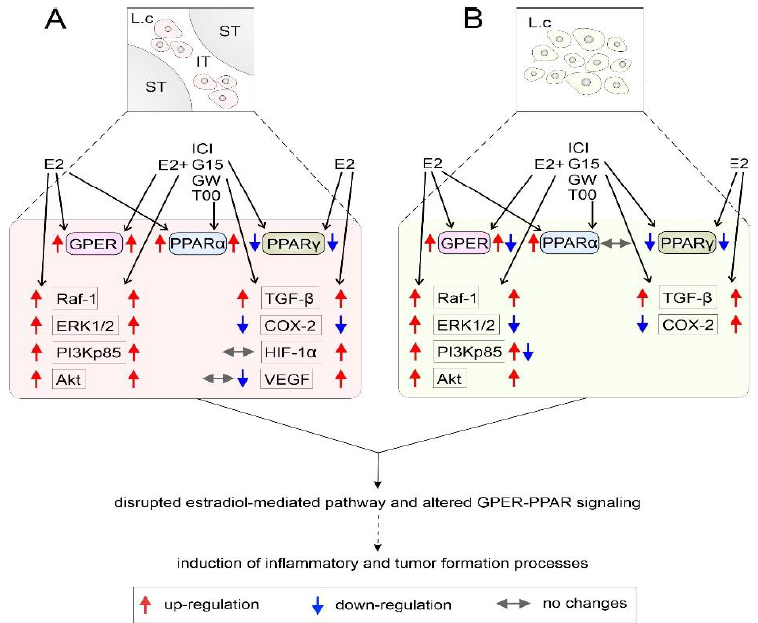
Figure 8. Schematic representation of local effects of estradiol alone or in combinations with GPER agonist and GPER and PPAR antagonists on the expression of Raf-1, ERK1/2, PI3Kp85 and Akt sig- naling proteins and TGF- β, COX -2, HIF- 1α, and VEGF in mouse testicular tissue ex vivo ( A ) and mouse MA-10 Leydig cells in vitro ( B ) . Estradiol alone and in mixtures (E2+ICI, E2+G-15, E2+GW, and E2+T00) acting via GPER and PPARs induces the activation of Raf-1/ERK1/2 and PI3Kp85/Akt pathways and alters the expression levels of tumorigenic factors. The most likely effects on cellular processes are marked with a dotted arrow. GPER — G protein- coupled estrogen receptor; PPARα— peroxisome proliferator- activated receptor alpha; PPARγ— peroxisome proliferator-activated re- ceptor gamma; ICI — GPER agonist; G-15 —PPARα antagonist; GW—PPARα antagonist; T00— PPARγ antagonist; E2— estradiol; Raf-1 — proto-oncogene serine-threonine-protein kinase; ERK1/2 — extracellular signal-regulated protein kinase; PI3K — phosphatidylinositol 3-kinase; Akt — protein kinase B; TGF- β—tumor growth factor β; COX -2 — cyclooxygenase-2; HIF- 1α— hypoxia in- ducible factor 1-alpha; VEGF — vascular endothelial growth factor; ST — seminiferous tubule; IT — interstitial tissue; Lc — Leydig cells. Supplementary Materials: The following supporting information can be downloaded at: www.mdpi.com/xxx/s1, Figure S1: Uncropped images of western blots presented in Figures 1 – 6. The cropped images shown in the main figures and their corresponding originals are versions taken at the same exposure level. Author Contributions: Conceptualization, M.K.-B. and E.G.-W.; methodology, E.G.-W. and M.D.; formal analysis, E.G.-W., M.D., M.K.-B. and B.B.; investigation, E.G.-W. and M.D.; data curation, E.G.-W. and B.B.; writing — original draft preparation, E.G.-W.; writing — review and editing, E.G.- W., B.B. and M.K.-B.; visualization, E.G.-W., M.K.-B. and B.B.; supervision, B.B. and M.K.-B.; project administration, E.G.-W. and B.B.; funding acquisition, E.G.-W., M.D., M.K.-B. and B.B. All authors have read and agreed to the published version of the manuscript. Funding: This research was funded by the National Science Centre (Poland) grant number OPUS12 2016/23/B/NZ4/01788. Institutional Review Board Statement: Sacrificing mice for testis collection was performed in ac- cordance with Polish regulations (Act of 15 January 2015 on the protection of animals used for sci- entific and educational purposes; Journal of Laws of 2015, item 266). The experiments were ap- proved by the Faculty of Biology at the Jagiellonian University, Poland (9 May 2019) and the allow-